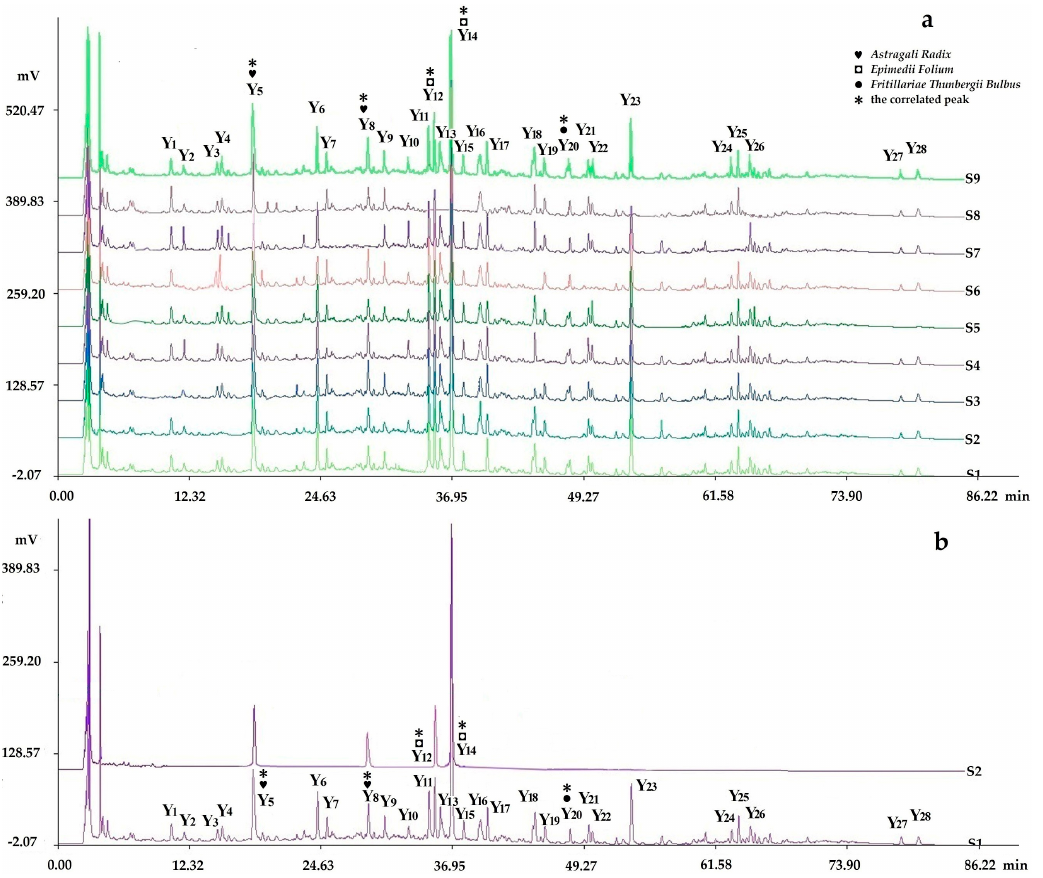
Figure 7. Chromatogram comparing the fingerprints analyzed by chromatographic condition II (HPLC-PDA) with negative control samples and reference standard samples: ( a ) S1–S8 were respectively the negative sample without Cervi Cornu Pantotrichum , without Fritillariae Thunbergii Bulbus , without Hirudo , without Ginseng Radix et Rhizoma , without Curcumae Rhizoma , without Sparganii Rhizoma , without Astragali Radix , and without Epimedii Folium , in which peaks 5 and 8 were from Astragali Radix ; peaks 12 and 14 were from Epimedii Folium ; and peak 20 was from Fritillariae Thunbergii Bulbus by comparing with the negative control solutions (S1–S8); ( b ) S2 and S1 were respectively the fingerprints of the reference standard solution and sample solution, in which peaks 8, 12, and 14(S) were identified as ononin, epimedin B, and icariin (reference peak) by comparing with the reference standard substance.